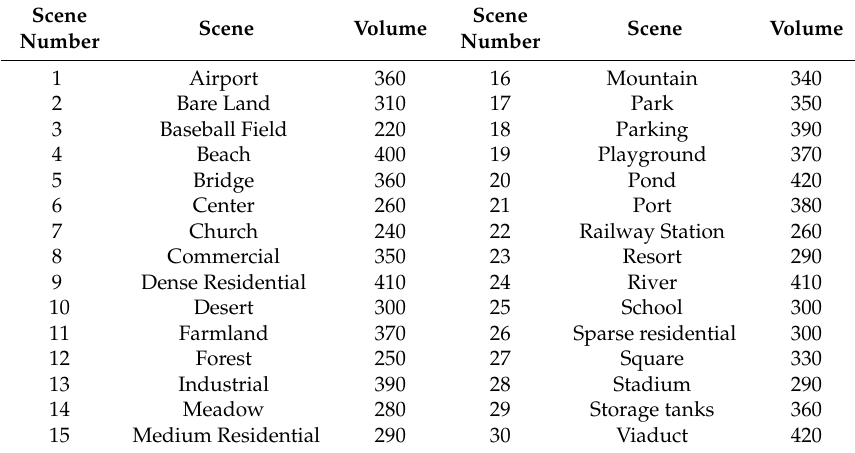
Table 2. Names and volume of different scenes in AID dataset.